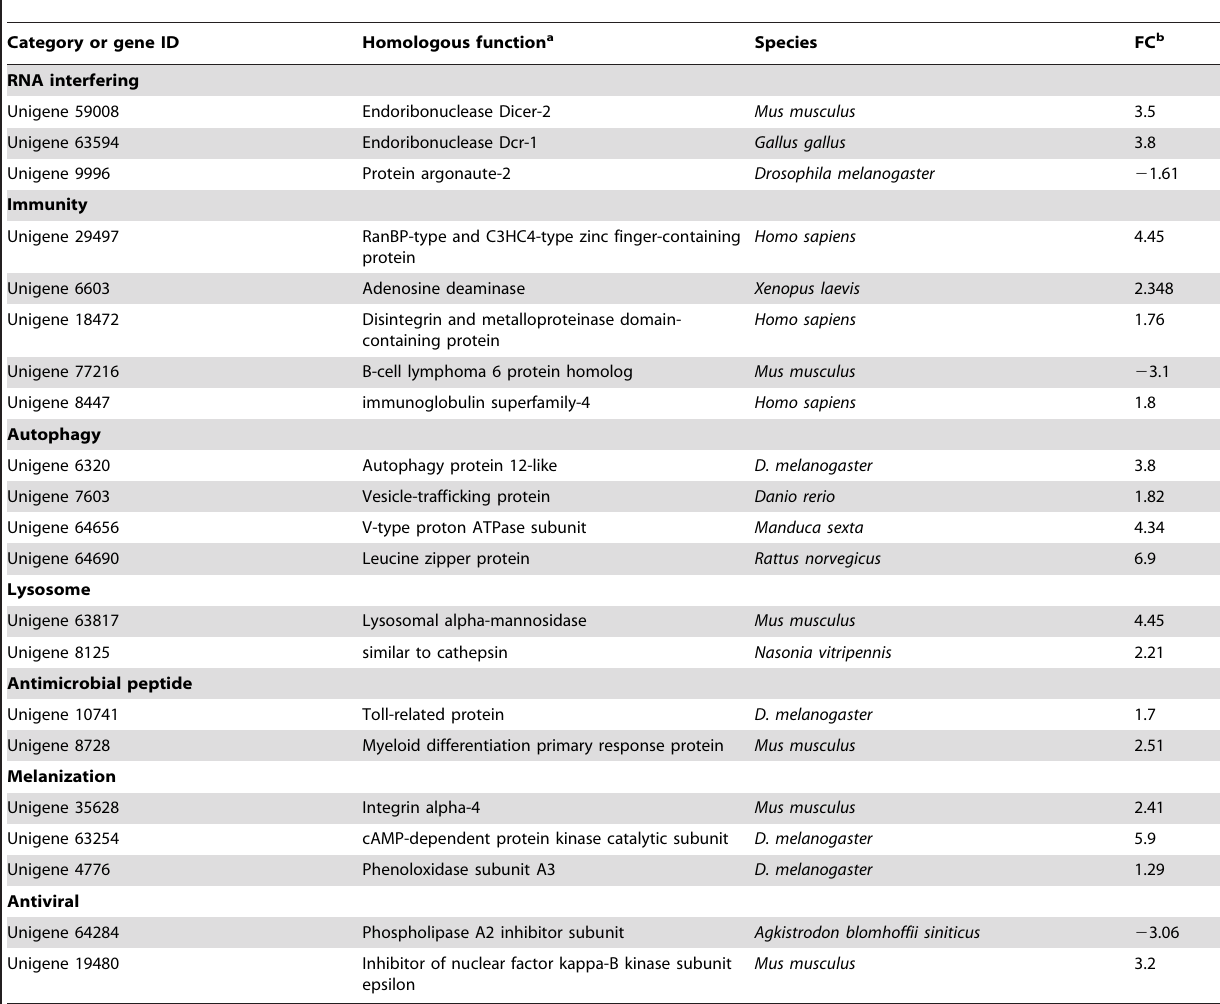
Table 4. Expression profiles of genes in the immune response